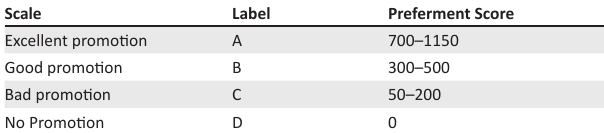
TABLE 1: Data classification of preferment